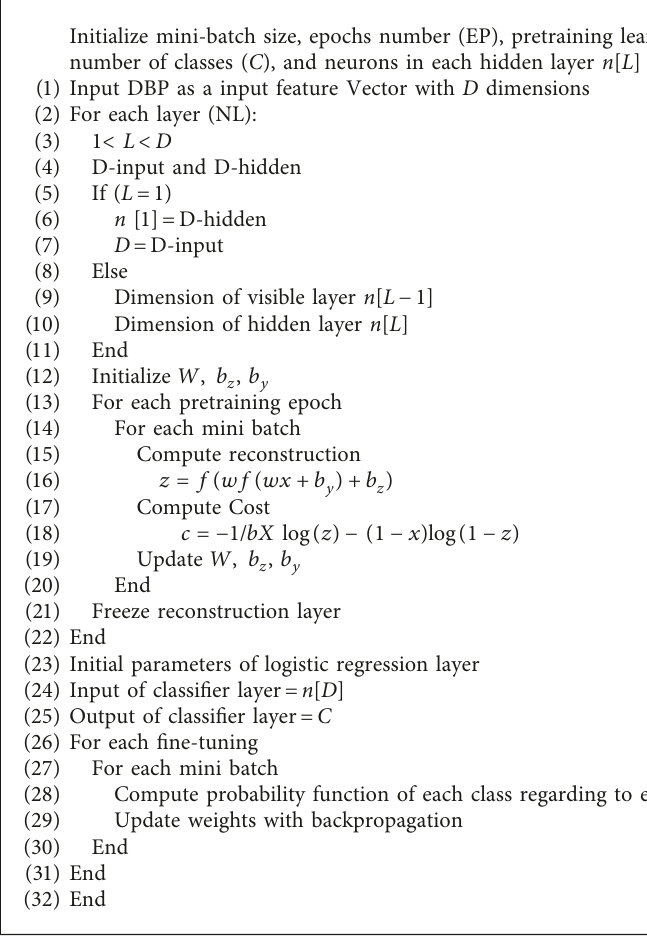
A LGORITHM 1:Pseudocode of DBP-DAE.